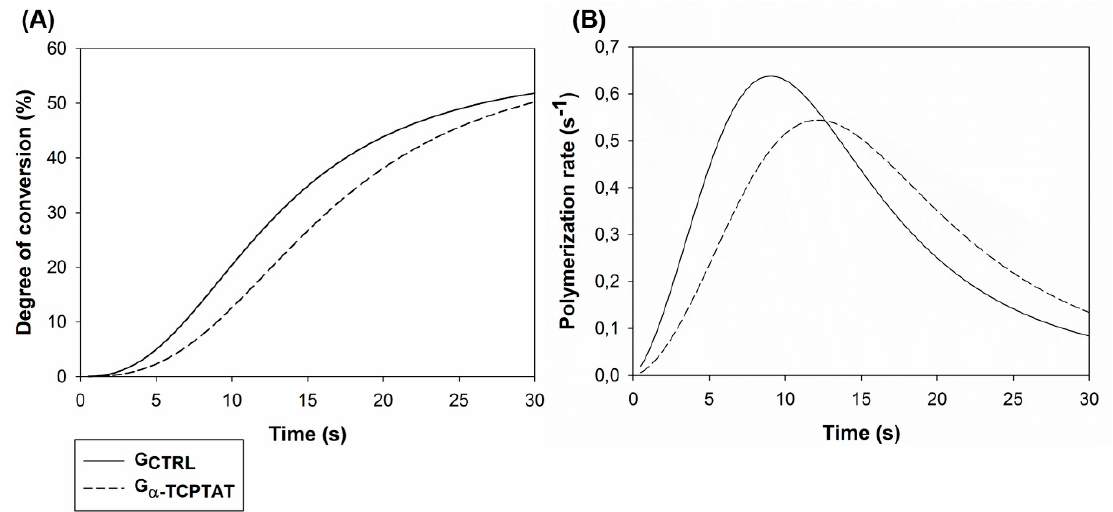
Figure 2. Polymerization behavior evaluation for 30 s of the experimental resin sealants. ( A ) DC % versus photoactivation time. ( B ) Rp versus photoactivation time.